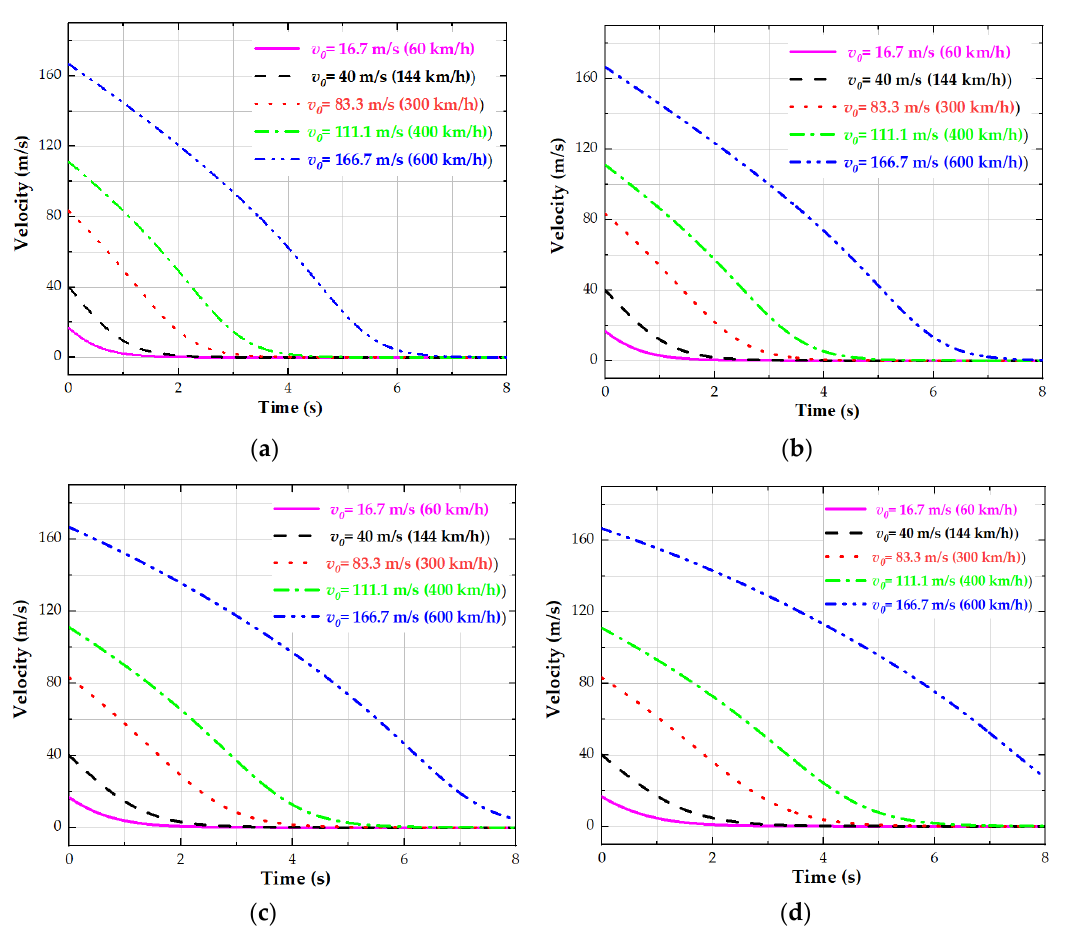
Figure 9. The change process of the vehicle’s velocity at initial speeds of V 0 = 60 km/h, 144 km/h, 300 km/h, 400 km/h and 600 km/h under different air gaps: ( a ) under 5 mm air gap, ( b ) under 10 mm air gap, ( c ) under 15 mm air gap, ( d ) under 20 mm air gap.